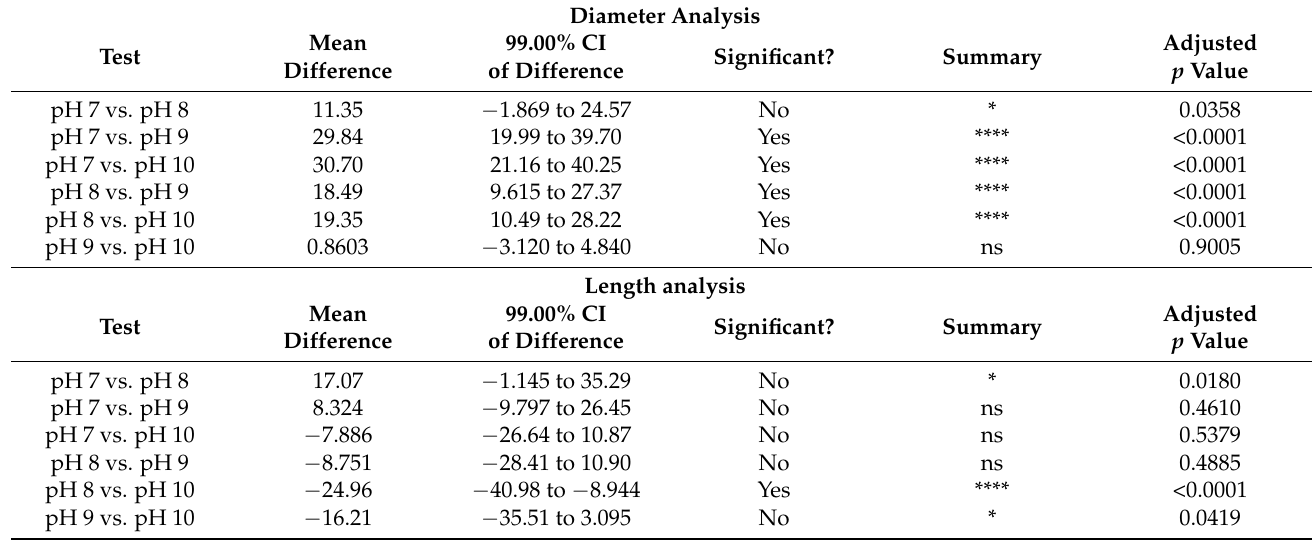
Table 3. Statistical analysis performed over the HAp dimensional